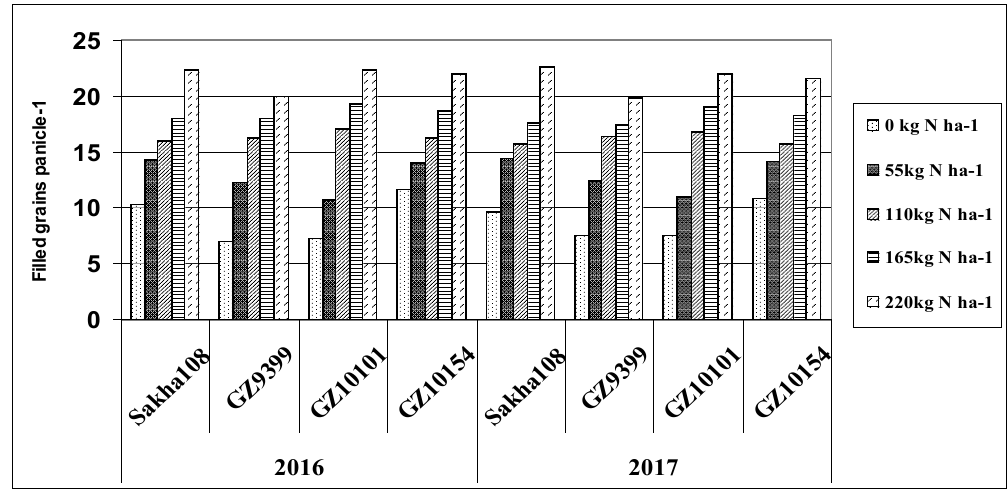
Figure 2: Number of panicles per hill as affected by interaction between rice genotypes and N levels in 2016 and 2017